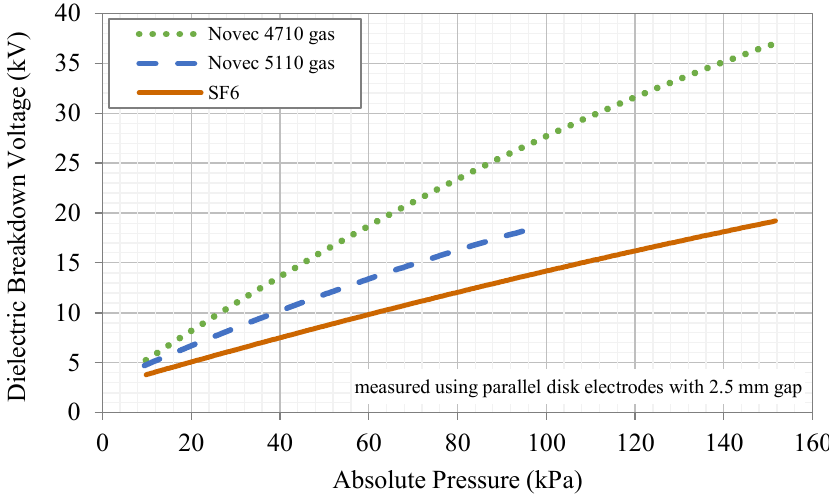
Figure 1. Dielectric breakdown voltage of pure gases [5].